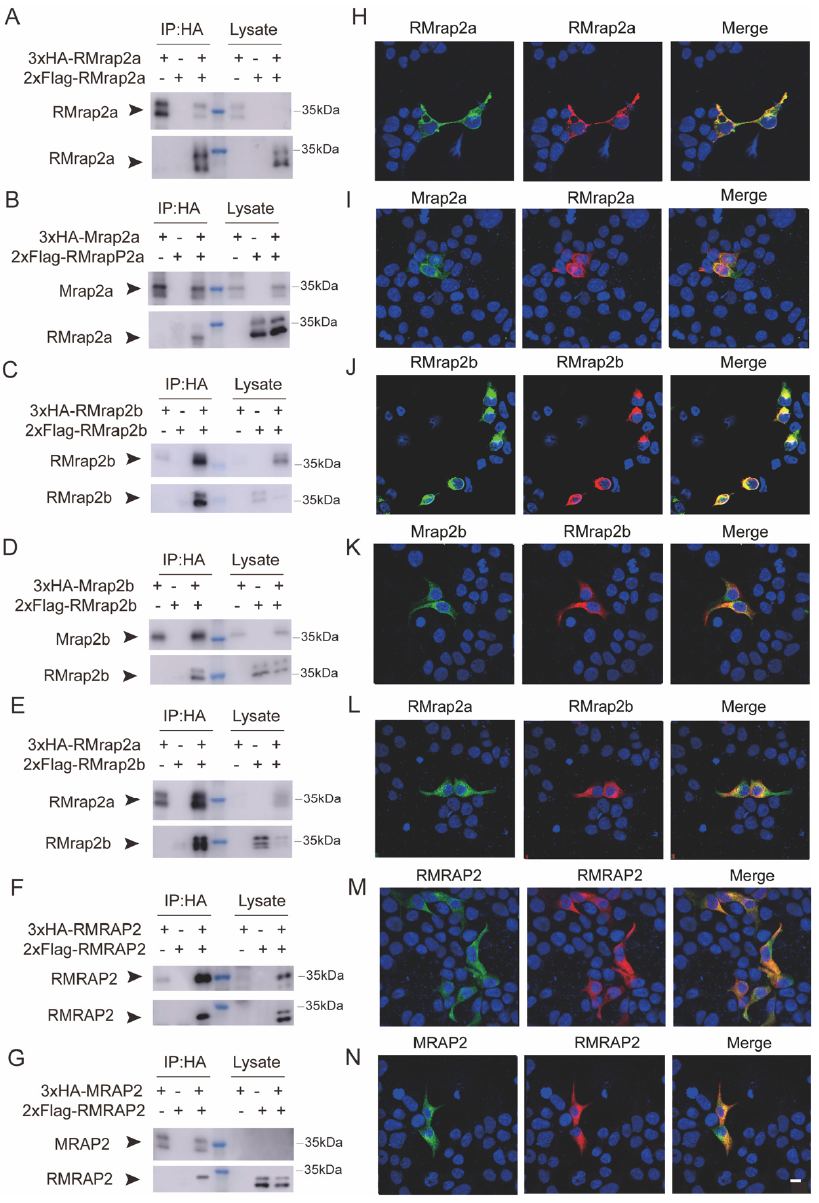
Figure 2. Formation of homodimers and heterodimers of RMRAP2 and RMrap2a/b. ( A , B ) The dimerization of RMrap2a with itself ( A ) or with Mrap2a ( B ). The blue marker indicates approximate Mol. wt. of RMrap2a and Mrap2a. ( C , D ) The dimerization of RMrap2b with itself ( C ) or with Mrap2b ( D ). ( E ) Co-immunofluorescence of RMrap2a and RMrap2b. ( F , G ) The dimerization of mouse RMRAP2 with itself ( J ) or with MRAP2 ( K ). ( H – N ) Immunofluorescence of the co-localization of the CoIP protein complexes on the plasma membrane. Scale bar = 10 µ m. The uncropped Western blot figures were presented in Figure